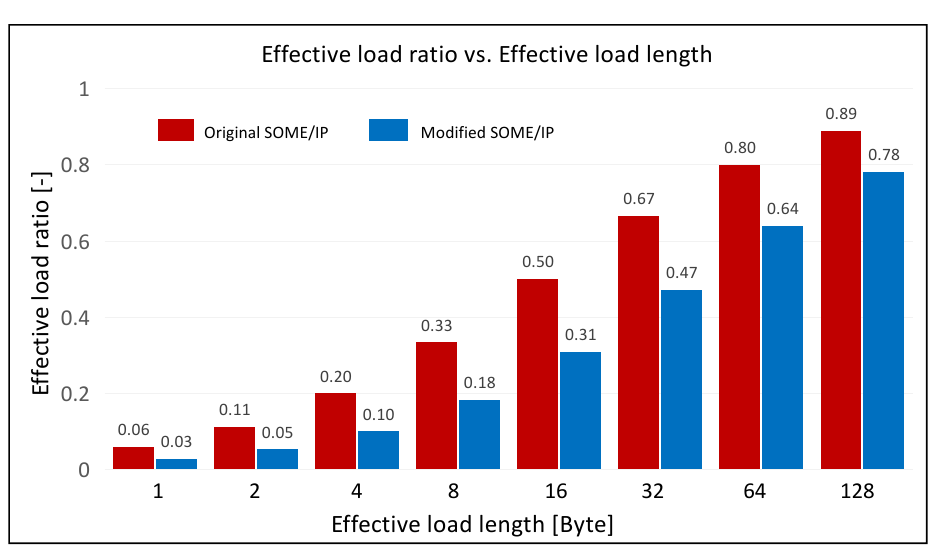
Figure 12. The changes in the effective load ratio with the effective load length.